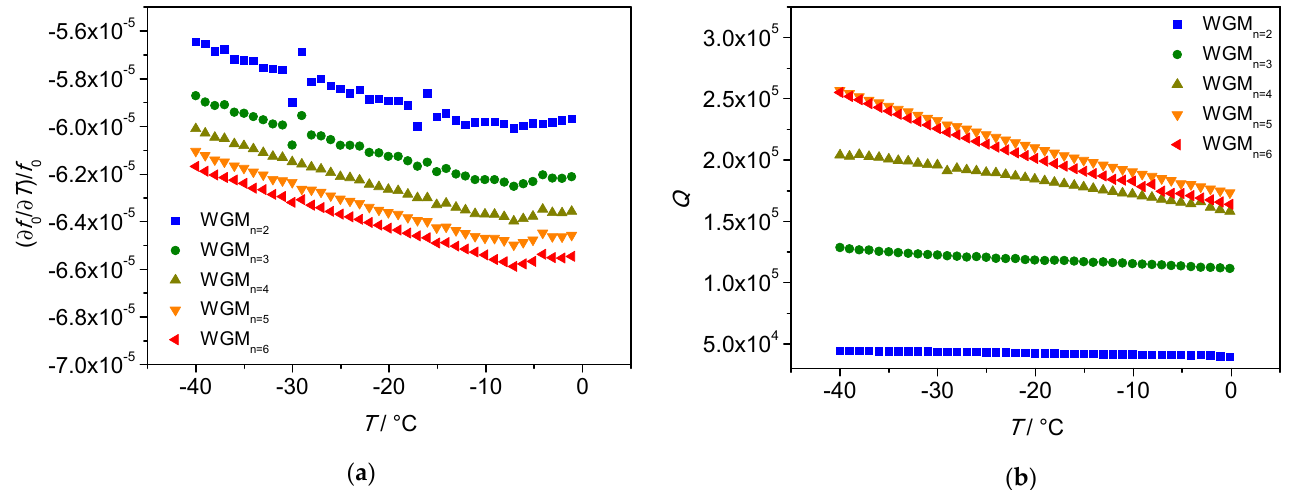
Figure 9. Measurements at five WGM resonances in the temperature range from − 40 to 0 ◦ C. ( a ) Frequency fractional change of the developed prototype as a function of the temperature. Small oscillations have been observed in WGM n=2 and WGM n=3 probably caused by issues in the temperature bath control system. ( b ) Q factor change with the temperature. Both fractional frequency change and Q factor are inverse functions of the temperature with a sensitivity depending on the selected whispering gallery mode. For instance, for WGM n=6 (14 GHz) the fractional frequency change varies from − 65 × 10 − 6 at 0 ◦ C to − 62 × 10 − 6 at − 40 ◦ C. These values are in accordance to that reported in the literature [9]. The highest Q factor is reached at 12 GHz by the WGM n=5 ; its value is 173,000 at 0 °C and becomes 257,000 at − 40 °C. Due to such a high Q factor and temperature sensitivity, the mode WGM n=5 at 12 GHz was selected for the operation of SWGT. The temperature cali- bration was then carried out in the whole temperature range and the experimental points (resonance frequency f 0 vs. temperature) were fitted using a 5th order polynomial [11]. The calibration curve and the fitting residuals are shown in Figure 10a,b, respectively. A weighted fit, carried out using the inverse of variance (1/ σ 2 ) as weight, resulted in fitting residuals of better than ±0.6 mK in the investigated temperature range. ( a ) 12220 12230 12240 12250 12260 12270 12280 12290-50-40-30-20-10010 203040 Data points Polynomial fit T e m pe r a t u r e / ° C